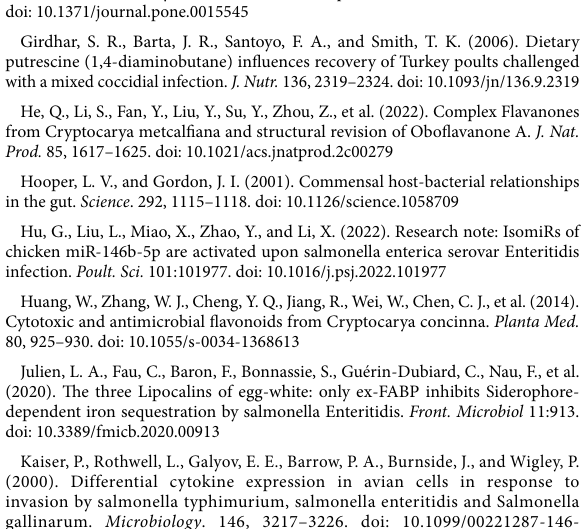
SUPPLEMENTARY FIGURE S1 Shannon index of CC, CT, RC, and RT. SUPPLEMENTARY FIGURE S2 Simpson index of CC, CT, RC, and RT. SUPPLEMENTARY TABLE S1 The 943 OTUs in 16S rRNA gene sequencing. SUPPLEMENTARY TABLE S2 The 525 differentially expressed genes in RNA-seq. SUPPLEMENTARY TABLE S3 The 125 metabolic pathways in PICRUSt1